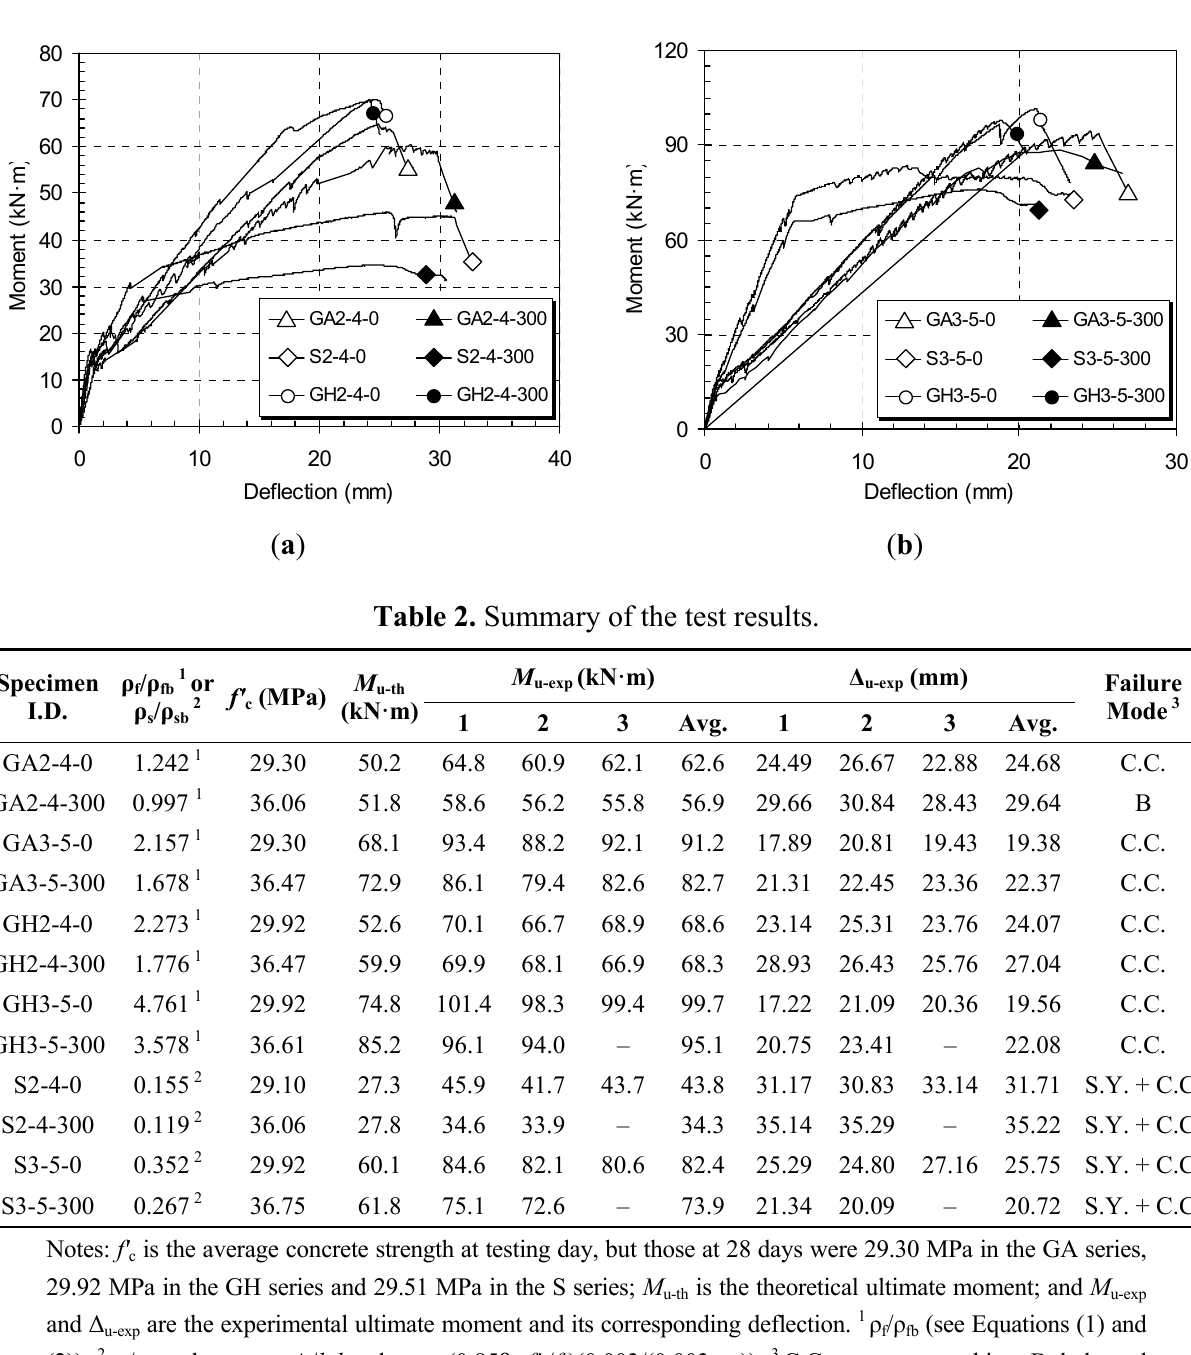
Figure 5. Moment-deflection curves: ( a ) the group of two #4 (GA2-4, GH2-4 and S2-4